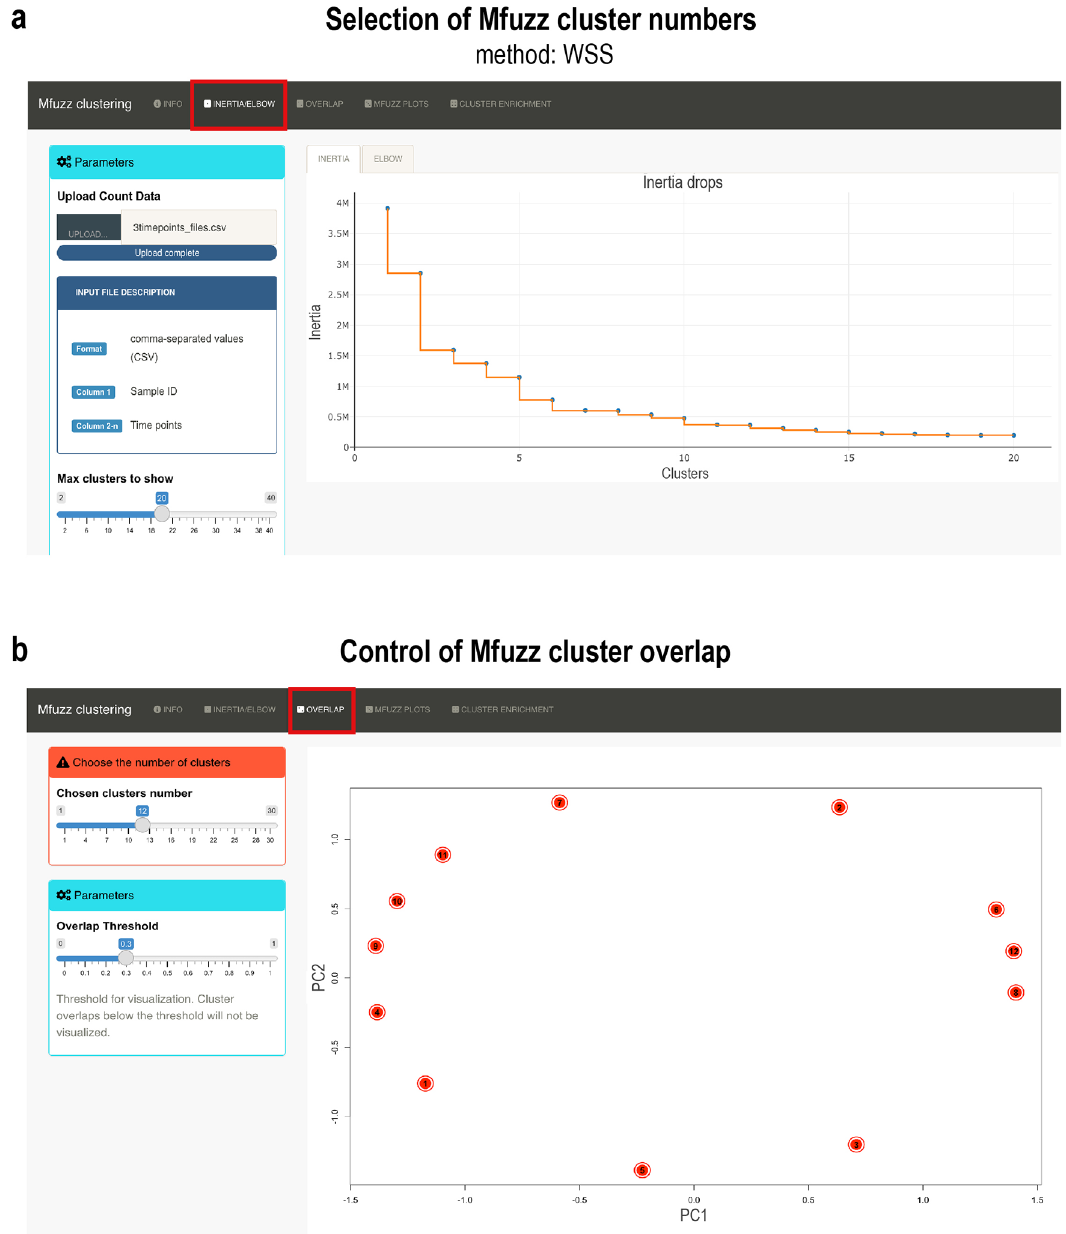
Figure 5. Pre-processing steps required for Mfuzz cluster analysis and cluster number selection. (a) Pre- clustering of data to select the cluster number for Mfuzz time-series clustering. The plot shows the intertia drops of the dendrogram. At 12 clusters, the inertia drop was minimal, suggesting that additional clusters would not provide better modelling of the data. (b) Control plot of Mfuzz cluster overlap. A PCA plot is performed with the selected 12 clusters, showing here that no overlap between clusters exists. Data from the developing Drosophila leg were chosen for demonstration Data preparation Tabula muris senis 15 limb muscle raw read data (data accessible at NCBI GEO database, 23 accession GSE132040) were taken as is and read into RNfuzzyApp for data processing and differential expression analysis. Raw read data from developing leg muscle 24 (data accessible at NCBI GEO database, accession GSE143430) were first averaged over replicates before reading them into RNfuzzyApp, as Mfuzz does not accept replicates (available as Habermann, Bianca; Haering, Margaux (2021), extended Datatables).